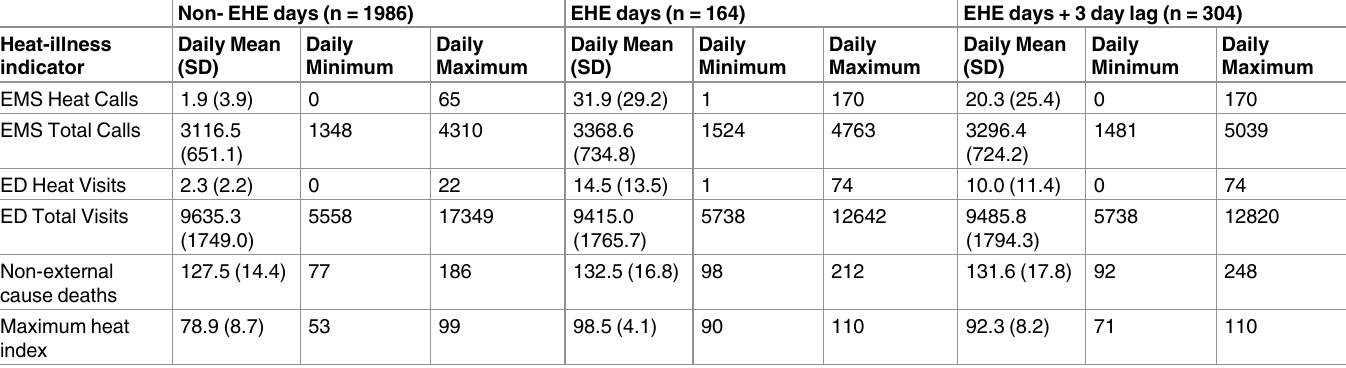
Table 1. Daily mean counts and range of EMS calls (1999–2013), ED visits (2002–2013), and non-external cause deaths (1999–2013) during non- extremeheat event (EHE) and EHE days between May and